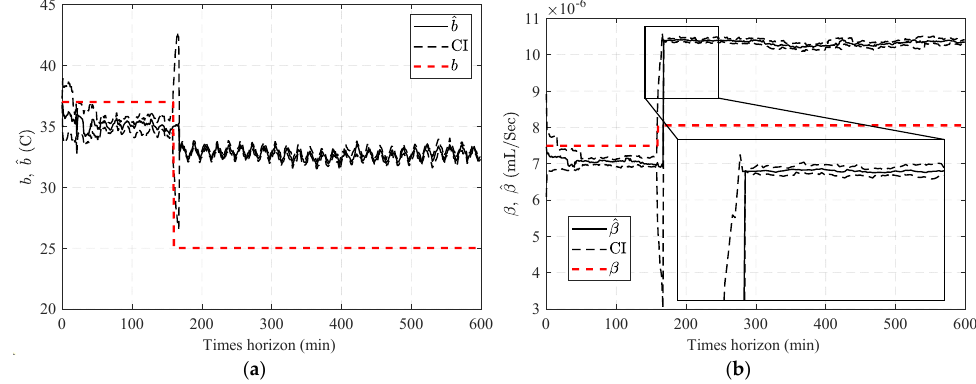
Figure 13. Result of the estimated ( a ) 𝑏(cid:3552) and ( b ) 𝛽 (cid:3552) using the one-step online parameter estimation method.